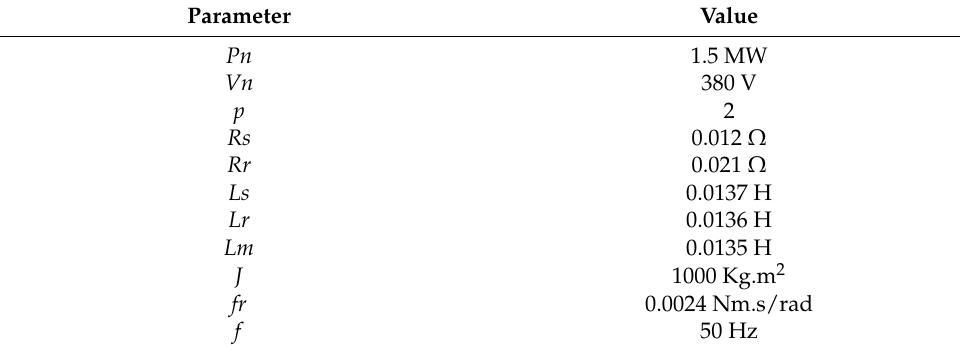
Table 1. Parameters of the simulated induction